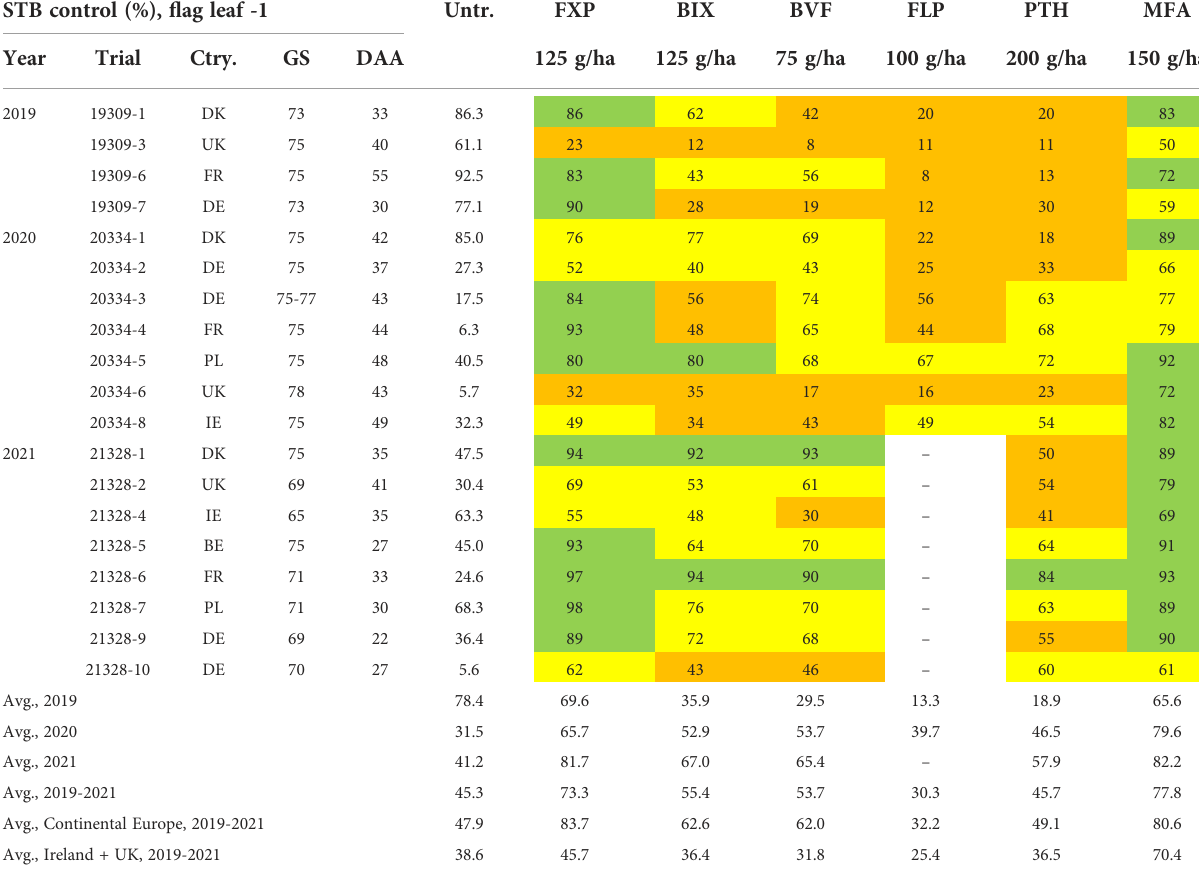
TABLE 4 Overview of septoria tritici blotch (STB) control and disease severity (%) in untreated (untr.) plots on fl ag leaves minus one (F-1). STB control (%), fl ag leaf -1